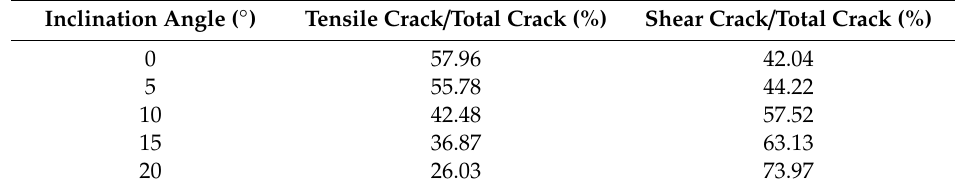
Figure 12. The average frequency ( AF ) and rising angle ( RA ) curves under different inclination angles at a loading rate of 1 mm/min: ( a ) 0°; ( b ) 5°; ( c ) 10°; ( d ) 15°; ( e ) 20°; ( f ) 25°. Table 5. Proportion of tensile and shear cracks under di ff erent inclination angles at a loading rate of 1 Table 5. Proportion of tensile and shear cracks under different inclination angles at a loading rate of mm / min. 1 mm/min.